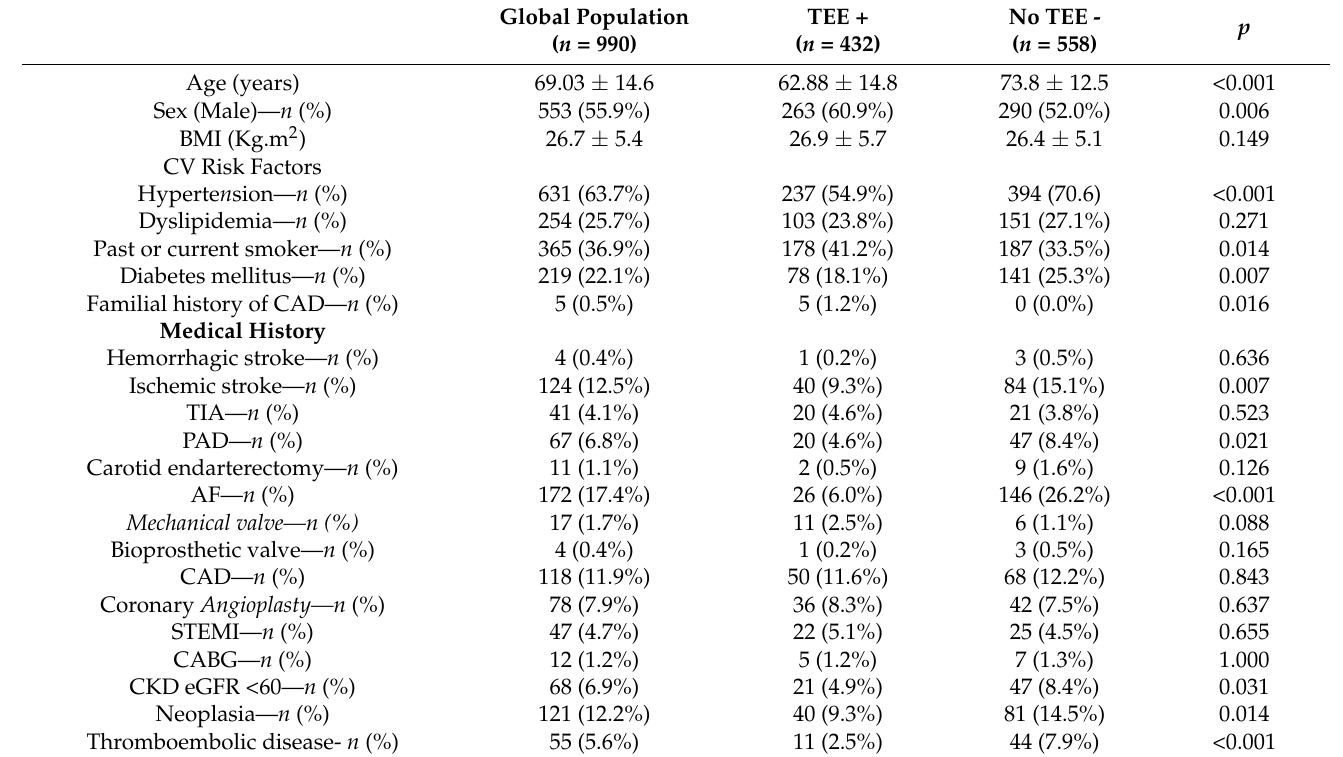
Figure 2. Flow Chart of the Study. Legends—among 990 patients admitted for stroke in Strasbourg Stroke center, France, a total of 432 hospitalized patients (42.6%) underwent TEE—365 (84.5%) for the evaluation of a documented acute ischemic stroke (AIS), 59 (13.7%) for transient ischemic attack (TIA) and 8 (1.8%) for a documented acute hemorrhagic stroke (AHS). Abbreviations—TEE = Transesophageal Echocardiography. Table 2. Patients Characteristics according to Transesophageal Echocardiography